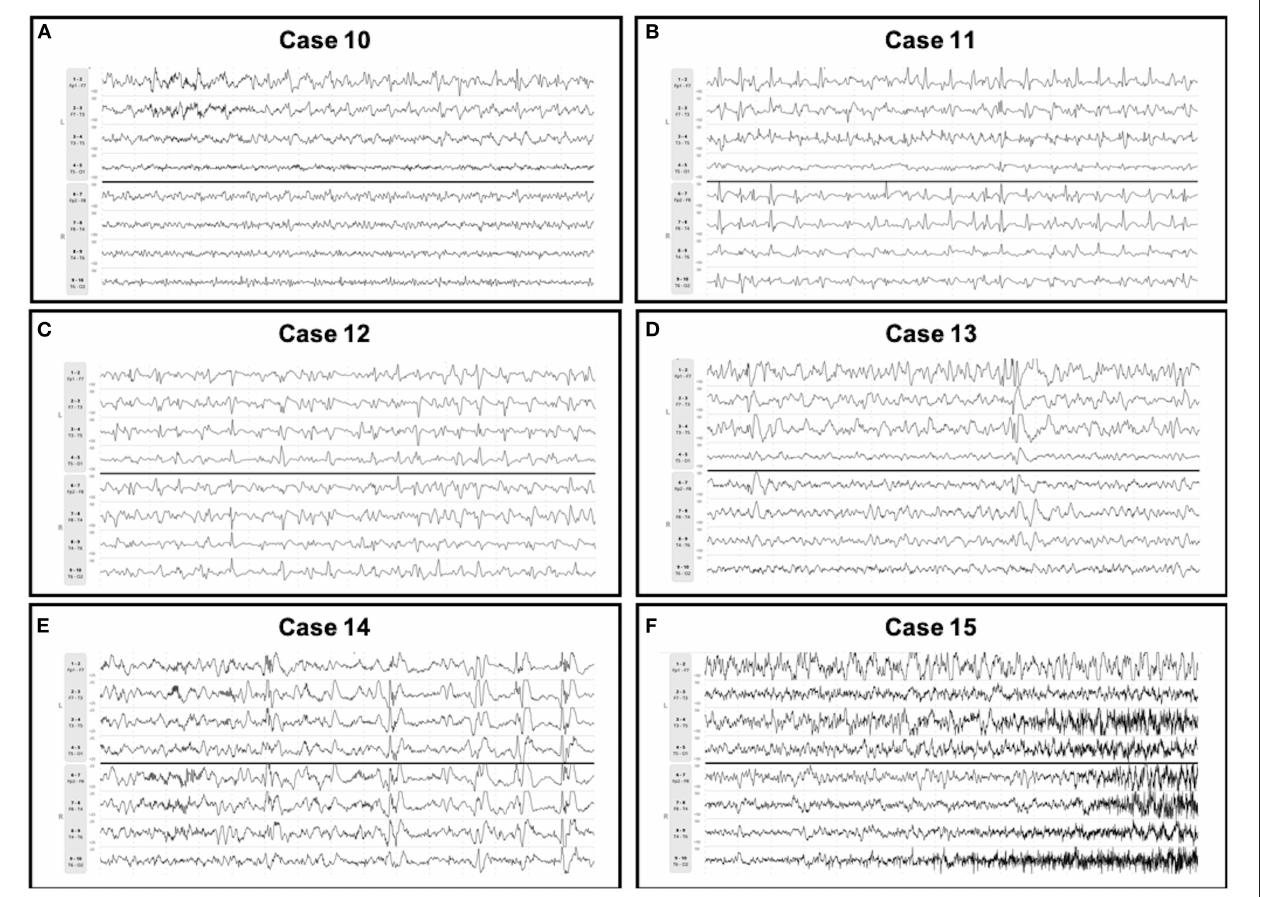
FIGURE 2 | Seizures detected on Rapid-EEG only. Seizures detected on Rapid-EEG (but not conventional EEG) in cases 10–15 were appropriately treated. Subsequent conventional EEG showed HEP of similar laterality in cases 10–12 and normal activity in case 13; conventional EEG data was unavailable for cases 14 and 15. Individual case descriptions corresponding to panels (A–F) are provided in Supplementary Data